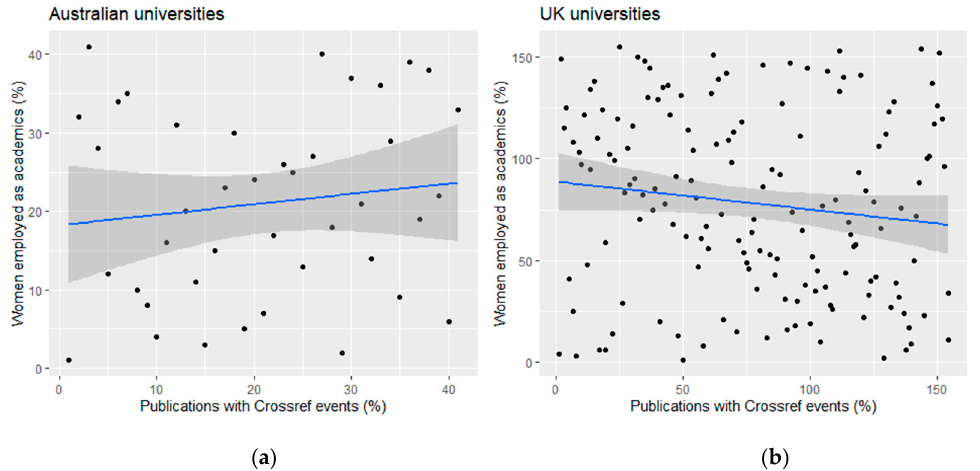
Figure 3. Scatterplot between ranks in percentages of women in academic roles and the percentages of outputs with Crossref events across ( a ) Australian and ( b ) UK universities, 2020. The data are presented in terms of ranks. Data sources: Department of Education, Skills and